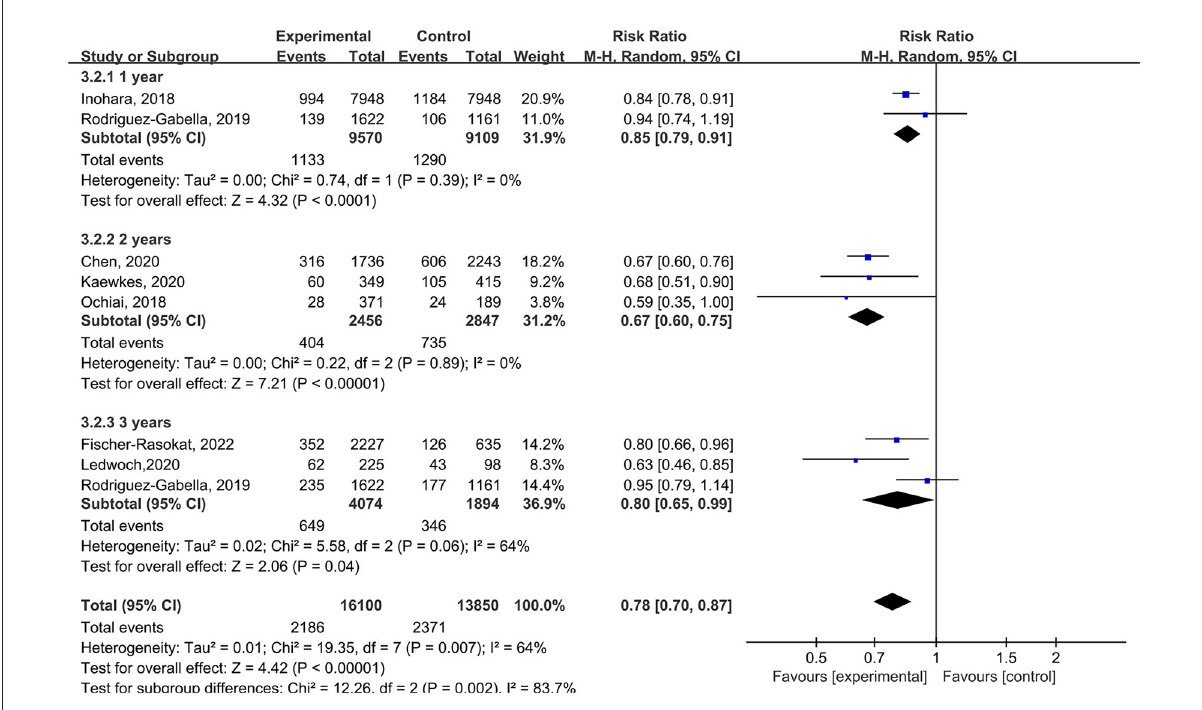
FIGURE5 Forest plots of random-effects meta-analysis for the rate of all-cause mortality by subgroups of the follow-up period.